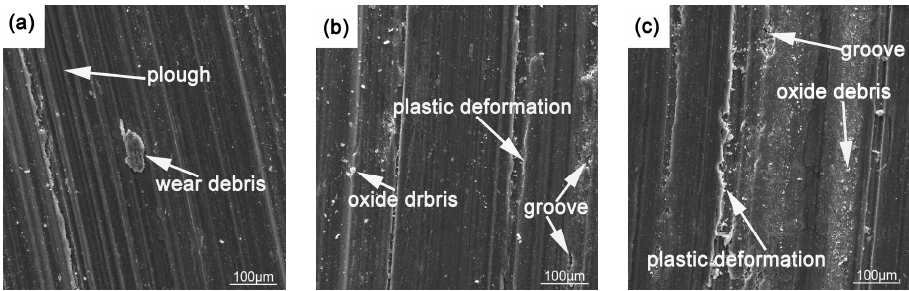
Figure 15. SEM images of worn surface for AZ91-1.5%Pr alloy under different applied loads ( a ) 30 N, ( b ) 60 N and ( c ) 90 N.